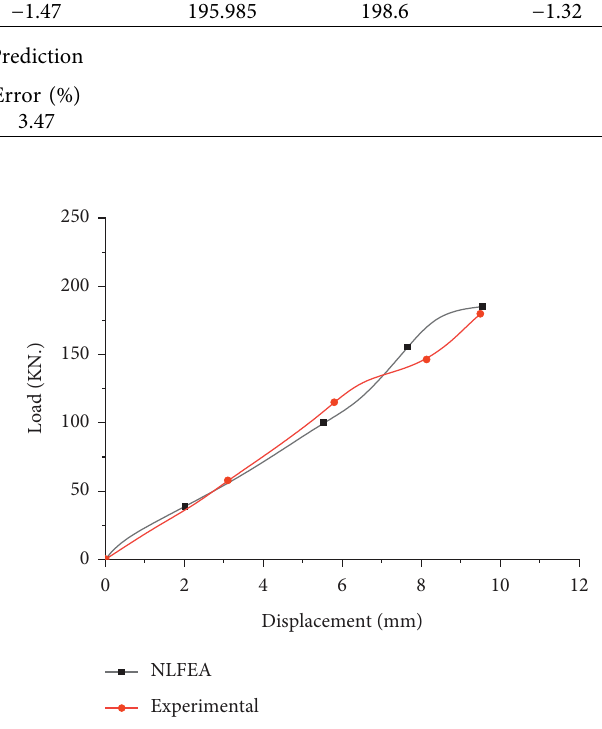
Figure 22: Load-displacement curve for specimen